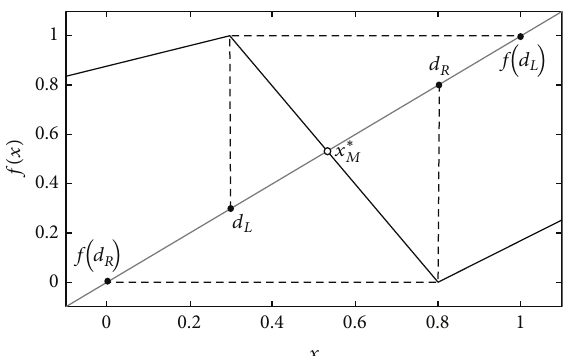
Figure 2: The map 𝑓 given in (2) for 𝑎 𝐿 = 0.4 , 𝑎 𝑅 = 0.8 , 𝑑 𝐿 = 0.3 , and 𝑑 𝑅 = 0.8